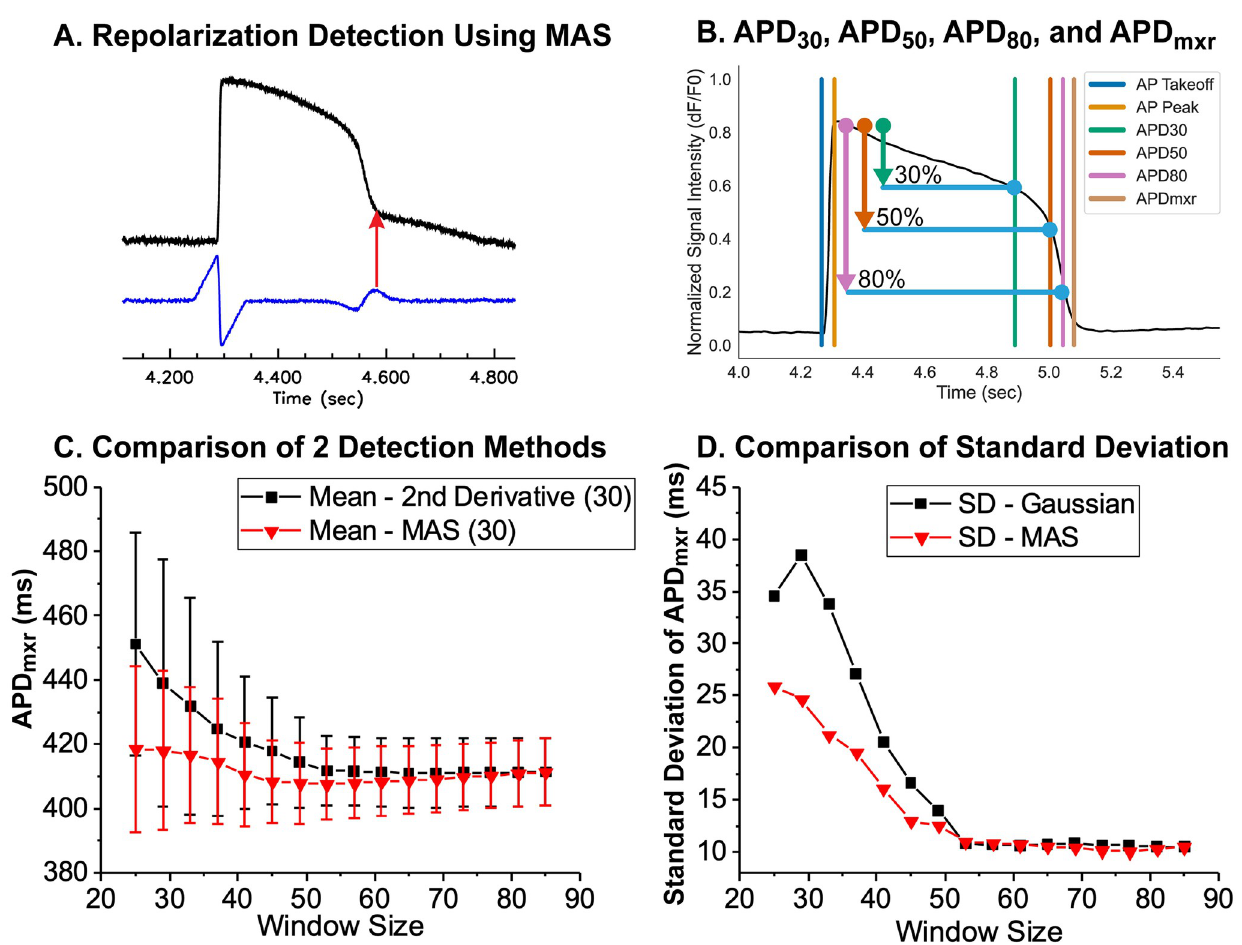
Fig 7. Detection of AP repolarization. (A) Repolarization time using moving average subtraction (MAS). MAS shows a secondary peak during the late phase of repolarization when the rapid repolarization slows down to reach the resting membrane potential. This time point is termed the maximum rate change of repolarization (APD mxr ). (B) Automatic detection of APD 30 , APD 50 , APD 80 , APD mxr from a sample AP recorded from a single microtissue. (C) Comparison of APD measurements using MAS vs. 2 nd derivative methods. A longer window size was required to measure APDs ( > 45) compared to AP upstroke analysis (~13, see Fig 6C). The mean value of APD using the MAS (red) method is less sensitive to the smoothing window size using the Gaussian 2 nd derivative method (black). (D) Increasing the smoothing window size reduces the standard deviation of APD measurements. N = 30 microtissues.